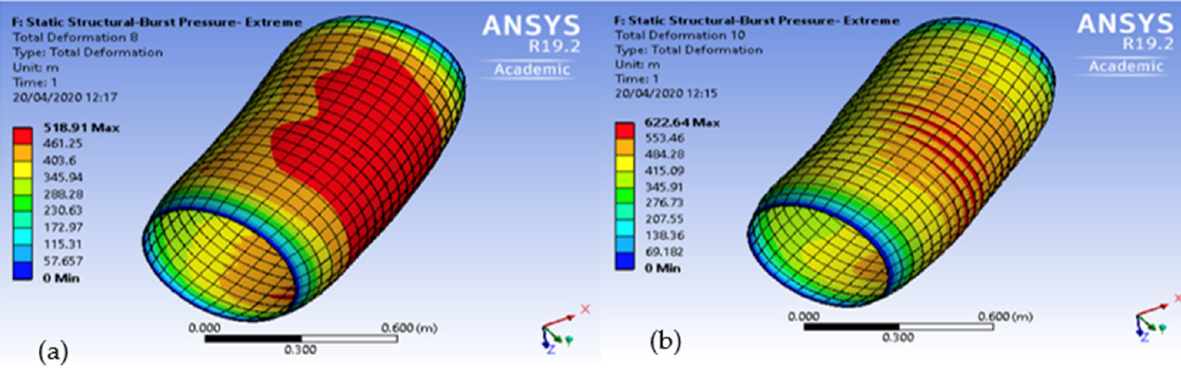
Figure 16. Layer wrinkling of different layers during extreme burst load for total deformation, for ( a ) Layer 8 and ( b ) Layer 10 .